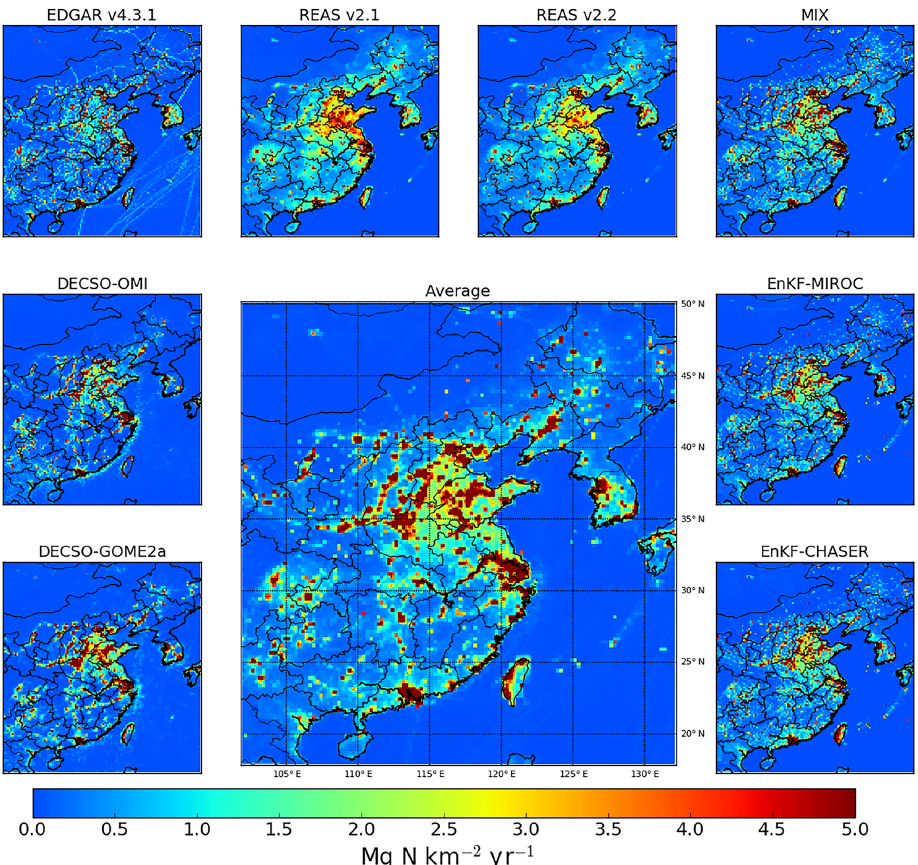
Figure 1. NO x emissions over East Asia of all inventories in this study and their average in 2008. The averaged emissions over land are the mean of all emission inventories. Over the ocean the emissions are the average of DECSO-OMI, DECSO-GOME2, REAS v2.2 and EDGAR